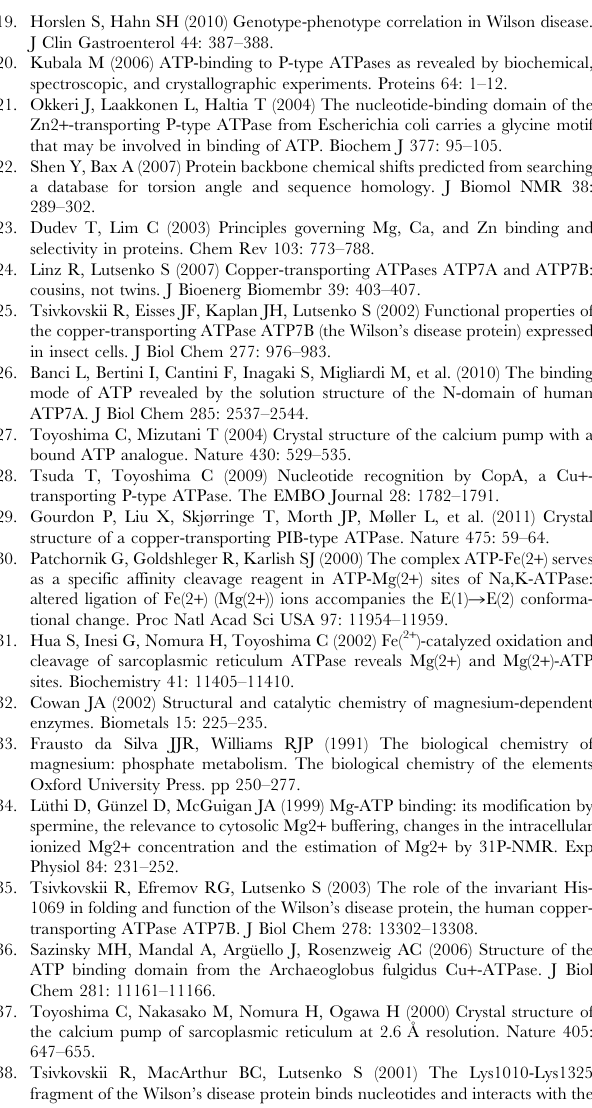
tion in the nucleotide-binding site. The distances (A˚ ) related to the octahedral coordination of the Mg 2 + are the average values over the last 20 ns of the total dynamic simulation (50 ns). Figure S7 MD analysis and alternative binding mode of the N- domain in absence of Mg 2 + for the WT-ATP system. (A) Plot of the Root Mean Square Deviation (RMSD, in A˚ ) of the C a ,atoms along the 50 ns of MD simulation for the WT-ATP system. (B) Closer trajectory snapshot of the representative structure along the last 20 ns of the 50 ns duration. Protein (WT), ATP molecule, and side-chain residues are represented in cartoon, ball and stick, and tube, respectively. Hydrogen bonds are shown in doted line. Figure S8 MD analysis and binding mode of the N-domain where the dynamic loop (A1114-T1143) has been shortened for the SL-Mg-ATP system. (A) Plot of the Root Mean Square Deviation (RMSD, in A˚ ) of the C a atoms along the 50 ns of MD simulation for the SL-Mg-ATP system (red). (B) Closer trajectory snapshot of the representative structure along the last 20 ns of the